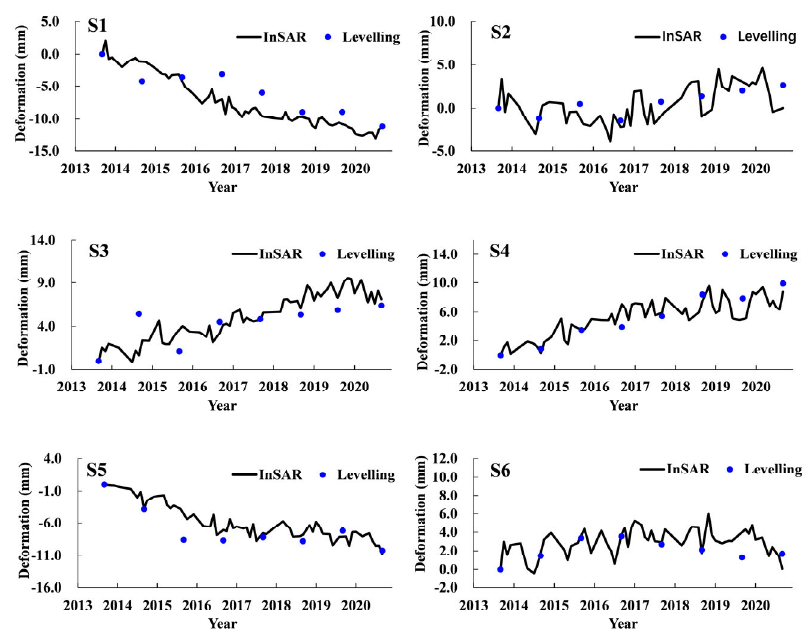
Figure 6. Time series of ground deformation data derived from InSAR and levelling between 2013 and 2020. Plots ( S1 – S6 ) shows the comparison of deformation time-series derived from InSAR and the corresponding levelling measurements at the six available levelling benchmarks, labeled as S1 , S2 , S3 , S4 , S5 , S6